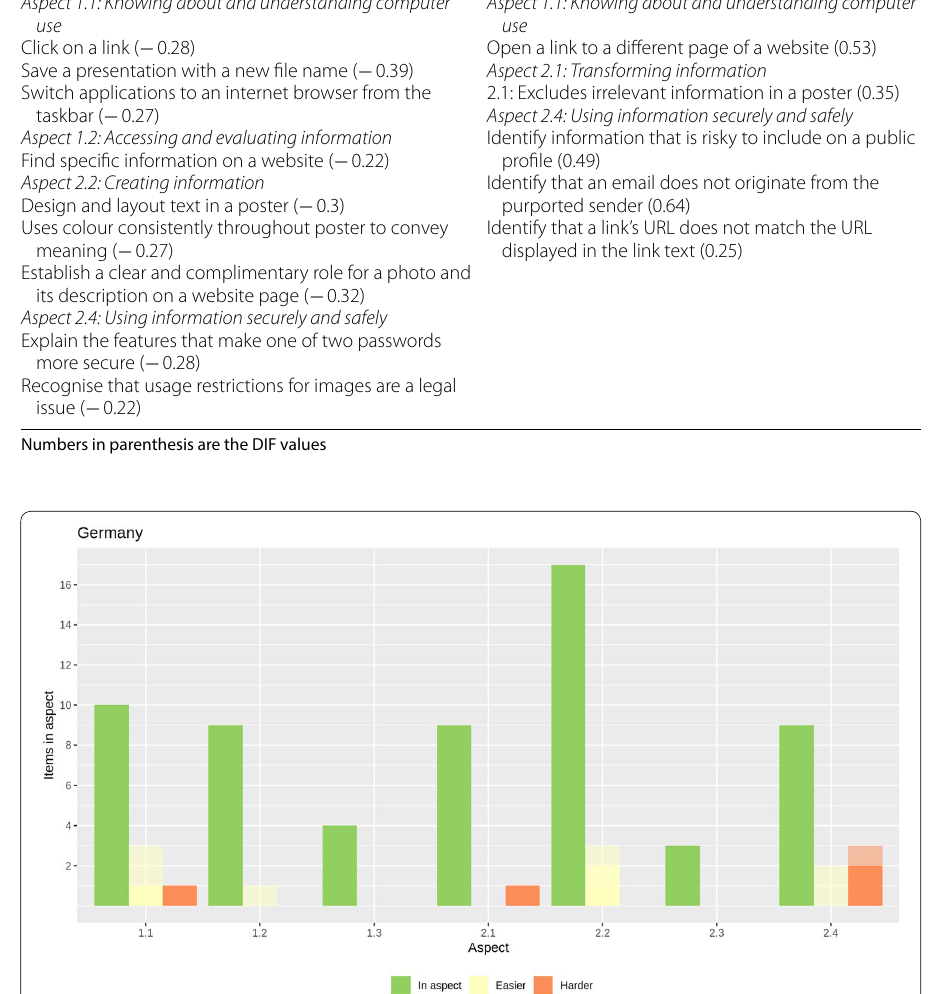
Table 4 Easier and harder items for German students Easier Harder Aspect 1.1: Knowing about and understanding computer